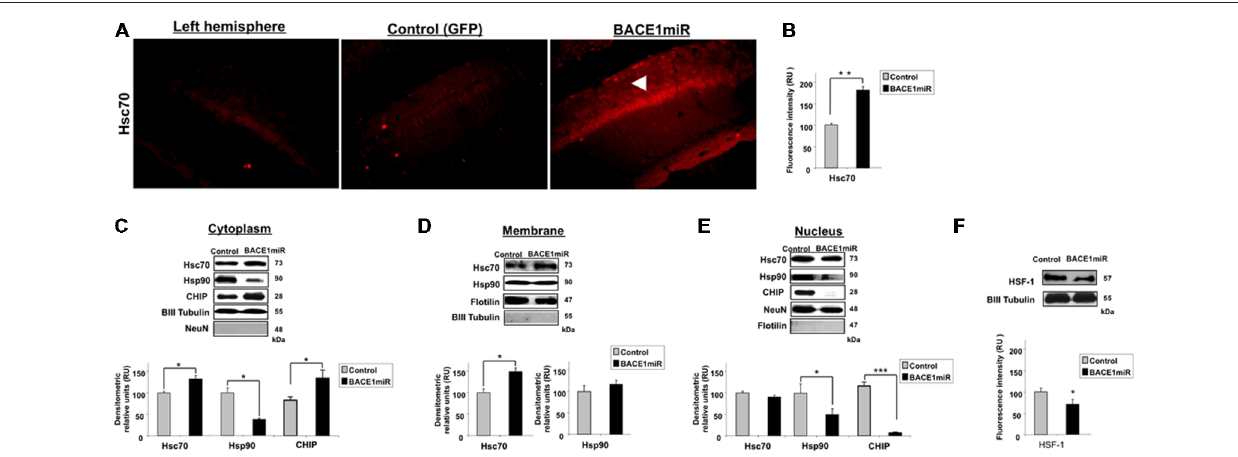
FIGURE 4 | BACE1miR decreases HSF-1, upregulates Hsc70 and induces differential cellular distribution of Hsc70 and Hsp90 in the hippocampus of 3xTg-AD mice. (A) Hippocampi of 18-month-old 3xTg-AD mice at 12 months after injection with AAV2/5-BACE1miR (BACE1miR) or AAV2/5-GFP (GFP). Immunofluorescence of Hsc70 in the CA1 region of 3xTg-AD mice. The white arrowheads show a significant increase in Hsc70 protein expression in the CA1 region that was injected with AAV2/5.BACE1miR compared to the left hemisphere (not injected) and to a right hemisphere injected with AAV2/5-GFP (control). Red: Alexa 594. 10X magnification, scale bar: 20 µ m. n = 3. (B) Graph of Hsc70 fluorescence intensity (red channel) in the CA1 area showing a significant increase of Hsc70 expression in BACE1miR-treated mice compared to the left hemisphere (not injected) and right hemisphere injected with AAV2/5-GFP (control). Quantification was performed using image Scope Pro software (Media Cybernetics); RU = relative units. n = 3, ∗ p < 0.05. (C) Cellular fractions from the hippocampi of 15-month-old 3xTg-AD mice that were treated with AAV2/5-BACE1miR (BACE1miR) or AAV2/5-GFP (GFP) for three weeks. Hsc70, CHIP and Hsp90 levels in the (C) cytoplasm, (D) membrane and (E) nuclear fractions. (F) HSF-1 protein expression in the hippocampi of 15-month-old 3xTg-AD mice at three weeks after injection with AAV2/5-BACE1miR (BACE1miR) or AAV2/5-GFP (GFP). Representative blots are shown. β III tubulin, flotillin and NeuN were used as loading controls or as fraction controls. Densitometric quantification was performed; RU = relative units. n = 6, ∗ p < 0.05, ∗∗ p < 0.001, ∗∗∗ p <